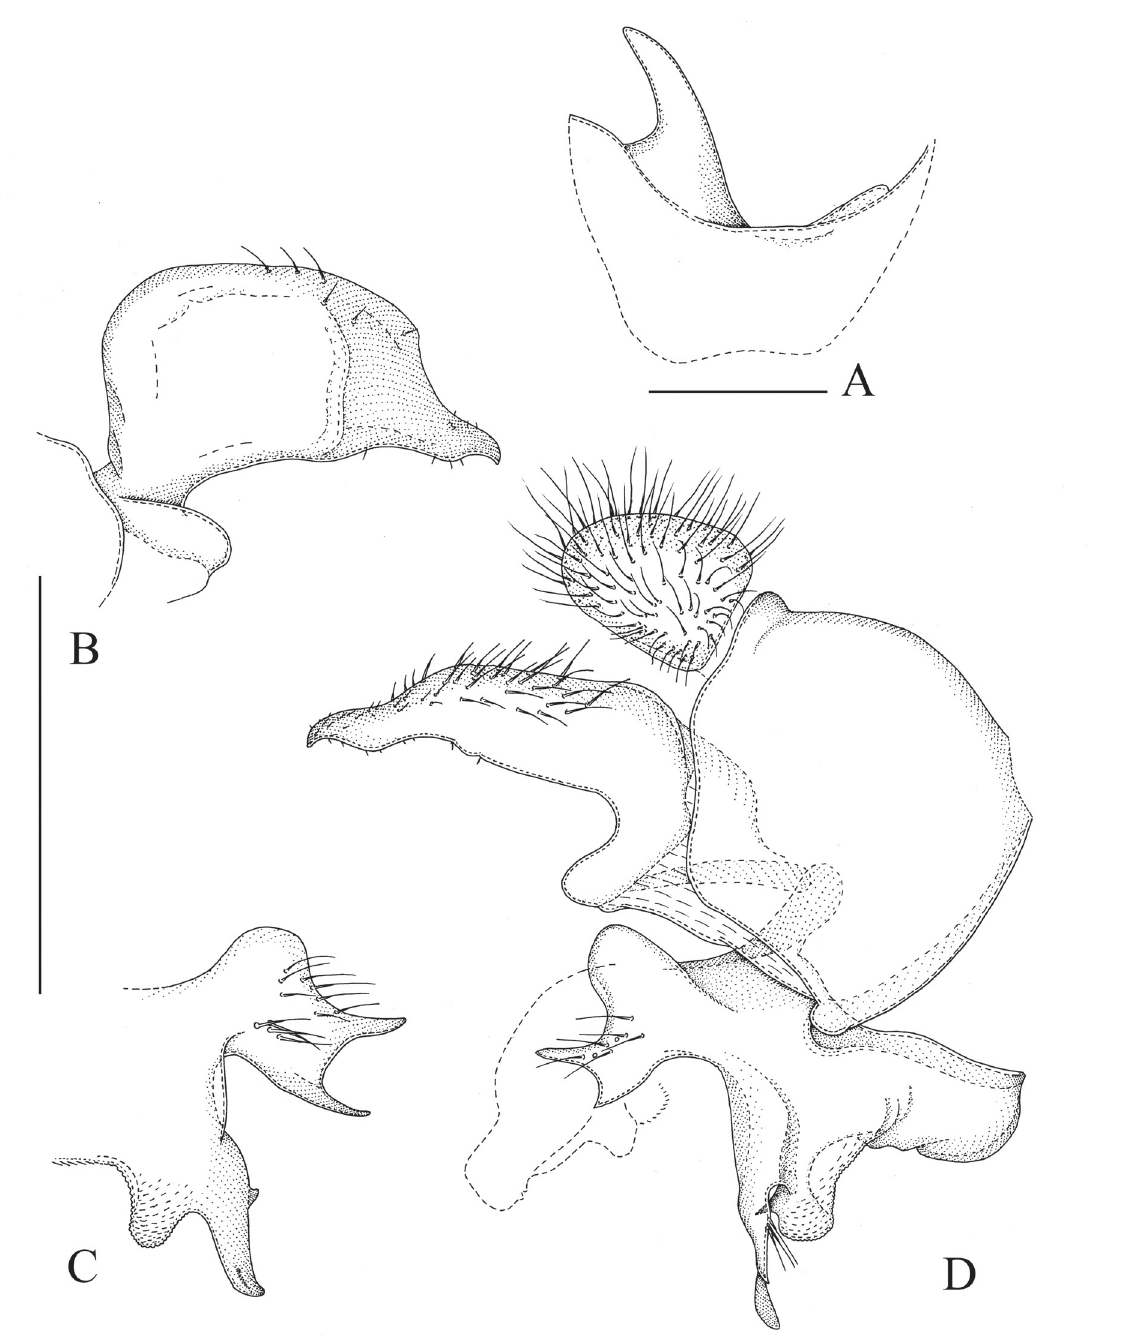
Fig. 8. Sphegina (Asio sphegina) amplistylus sp. nov., holotype, ♂ . A . Sternum IV, ventral view. B . Left surstylus, lateral view. C . Left superior lobe, lateral view. D . Genitalia, right side, lateral view. Scale bars = 0.5